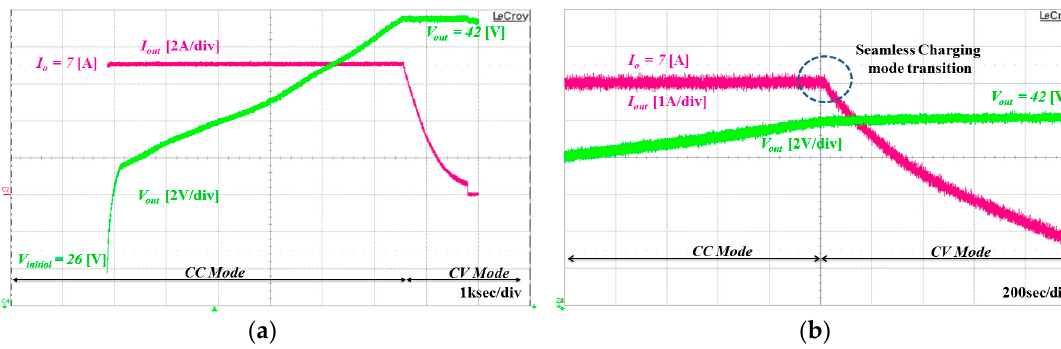
Figure 13. Experiment waveform during the CC-CV charging process: ( a ) during the whole charging period, ( b ) magnified waveform under the mode change.